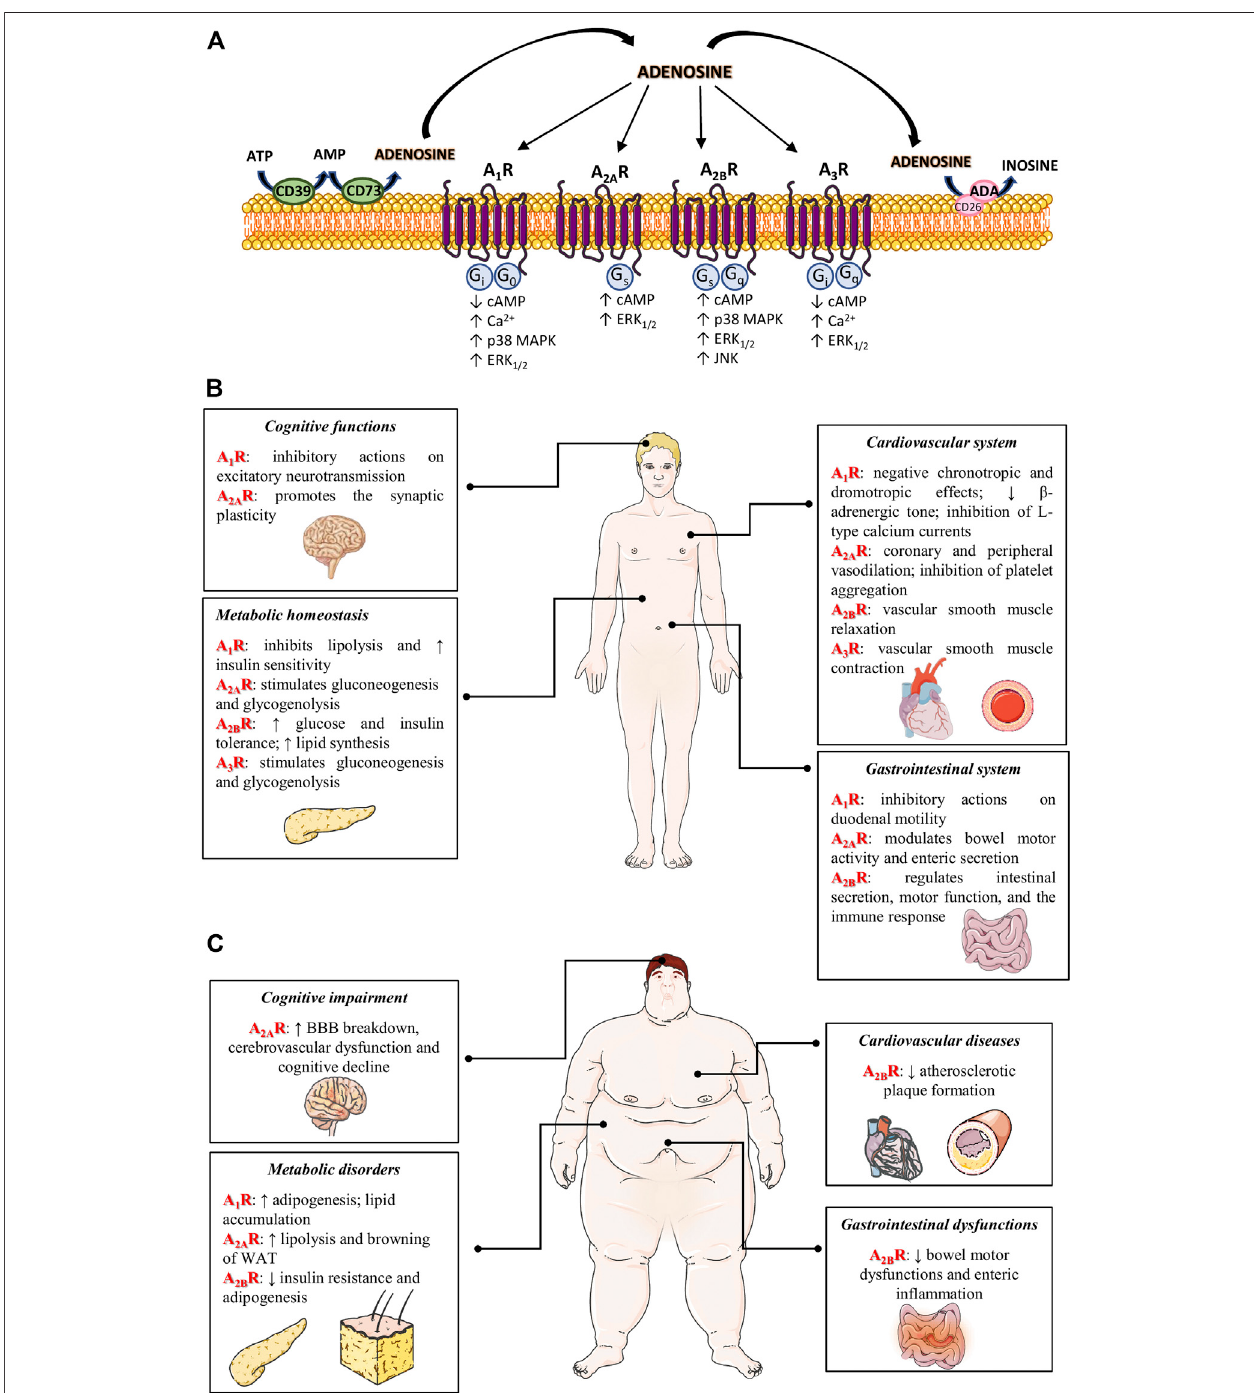
FIGURE 1 | (A) Adenosine receptor signaling. The extracellular adenosine is mainly produced by the ectonucleotidases, CD39 and CD73. Excess adenosine is irreversibly deaminated to inosine by ADA. Adenosine can bind to four different G protein-coupled adenosine receptors, that either inhibit (A 1 R and A 3 R) or stimulate (A 2A R and A 2B R) adenylyl cyclase activity and cAMP production in the cell. All ARs are coupled also to MAPK pathways, including ERK 1/2 and p38 MAPK. (B) Actions of adenosinereceptors onvariousorgan under physiological conditions. In CNS, A 1 Rs exertinhibitoryactions on excitatory neurotransmission, while A 2A Rs promote excitatory actions. In cardiovascular system, the engagement of A 1 Rs and A 3 Rs triggers the vascular smooth muscle contraction, whereas the activation of A 2A Rs and A 2B Rsmediatesthevascularsmoothmusclerelaxation.Inaddition,A 1 RactivationtriggersnegativechronotropicanddromotropiceffectsandA 2A Rengagementinhibits plateletaggregation.In gastrointestinal system, theactivation ofA 1 Rs,A 2A Rsand A 2B Rsregulatesintestinal secretion and motor function. Furthermore, theactivationof A 2A Rs and A 3 Rs stimulates gluconeogenesis and glycogenolysis; while, A 1 Rs and A 2B Rs inhibit lipolysis and increase the lipid synthesis. (C) Actions of adenosine